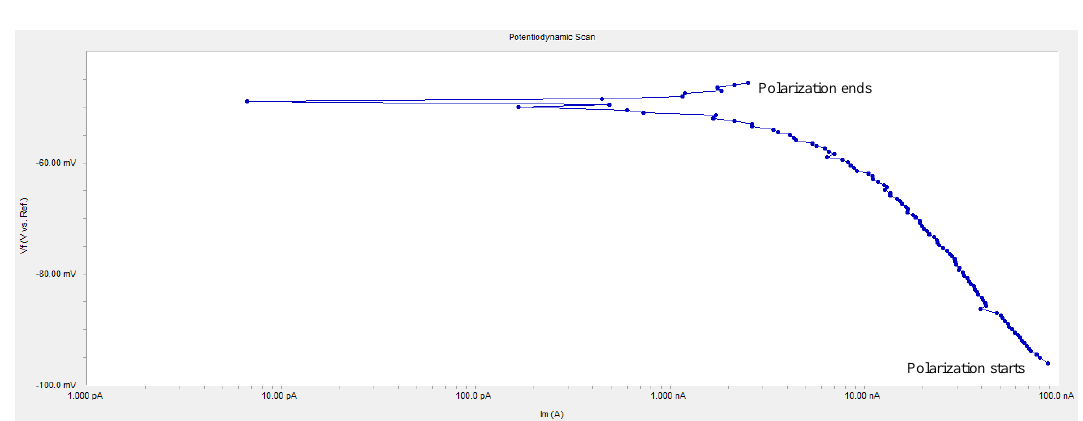
Figure 10. Anodic polarization curve of monitoring point